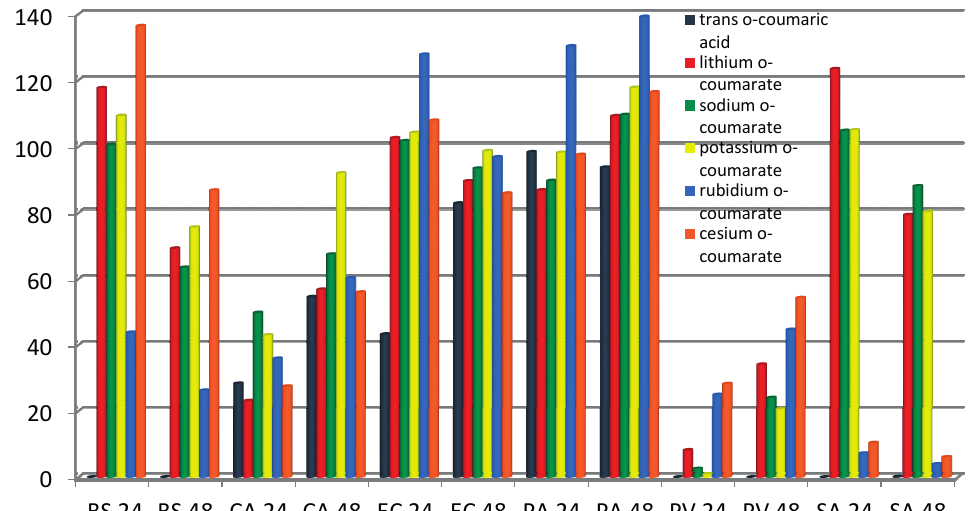
Figure 9. The degree of growth inhibition induced by the studied compounds in Baccillus ssubtilis (BS), Candida albicans (CA), Escherichia coli (EC), Pseudomonas aeruginosa (PA), Proteus vulgaris (PV) and Staphylococus aureus (SA); evaluated after 24 and 48 h of